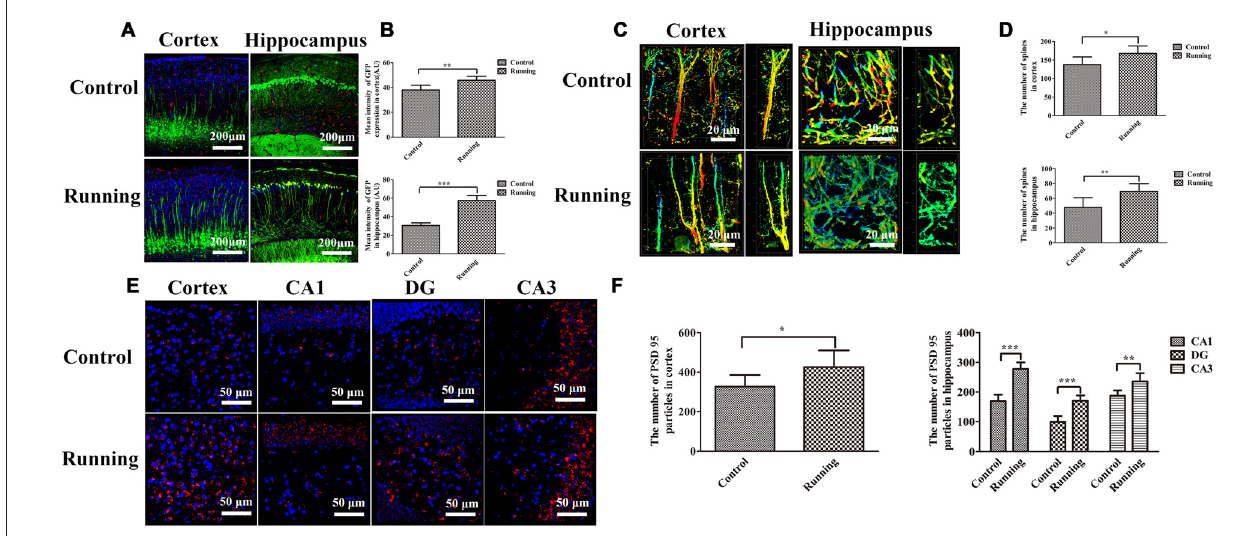
FIGURE 7 | Effects of voluntarily running on synaptic function detected in Thy1 –green fluorescent protein (GFP) transgenic mice and on immunofluorescent staining for postsynaptic density protein (PSD95). (A) Immunofluorescent staining of IBA1-positive cells in the cortices and hippocampi of Thy1 –GFP mice in the control and running groups (250 × , scale bar = 200 µ m). (B) Histogram comparing the GFP intensity in the cortices and hippocampi of the control and running groups. (C) Representative images of dendrites and dendritic spines in the cortices and hippocampus of the control and running groups (630 × , zoomed in three-fold, scale bar = 20 µ m). To show the spines more clearly, the images were coded with different colors. (D) Histogram comparing the number of spines in the cortices and hippocampi of the control and running groups ( n = 6 per group). (E) Immunofluorescent staining of PSD95 in the cortices and hippocampi of the control and running groups (630 × , scale bar = 50 µ m). (F) Histogram comparing the PSD95-positive particles in the cortices and hippocampi of the control and running groups ( n = 6 per group). Datasets are expressed as means ± SD, n = 6. ∗ P ≤ 0.05; ∗∗ P ≤ 0.01; ∗∗∗ P ≤